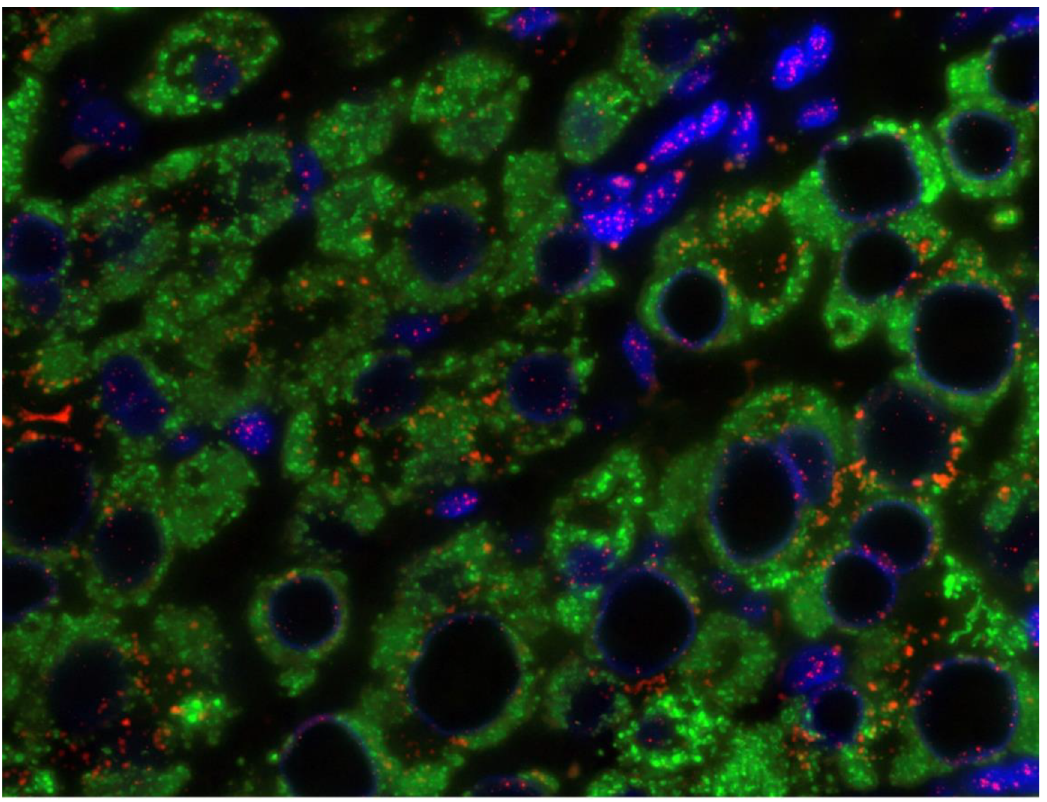
Fig 2. Q-FISH of liver tissue in chronic HBV infection. Hepatocytes with cytoplasm stained green with antibody to Hepar-1, nuclei stained blue with DAPI and telomeres shown in pink. Note vacuolated nuclei with peripheral telomeres as seen in senescence (13). doi:10.1371/journal.pone.0127511.g002 contrast no effect on HBsAg or HBV DNA production was observed in senescent cells, with only a modest increase in cytoplasmic HBcAg staining.